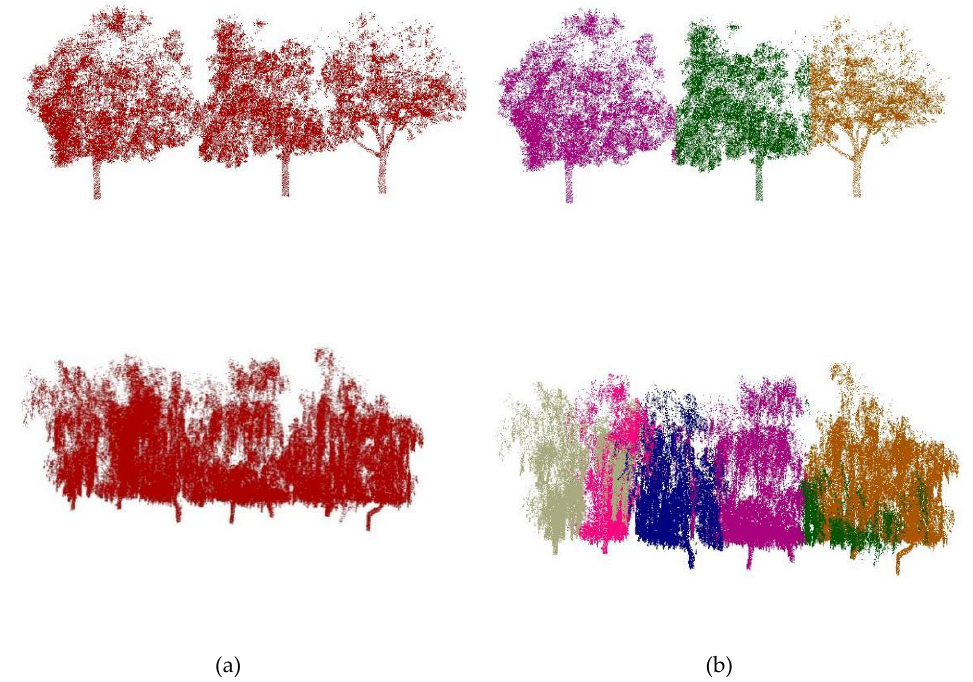
Figure 12. Results of single tree segmentation constrained by Voronoi graph. ( a ) represents the unsegmented tree points, ( b ) represents the single tree result represented by different colors after Voronoi graph segmentation.